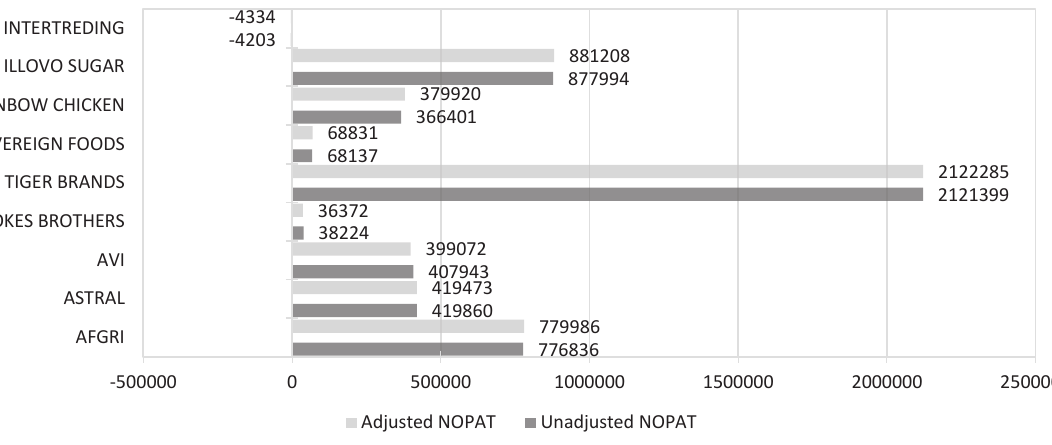
Figure 2. The unadjusted NOPAT and the adjusted NOPAT (Rand values in